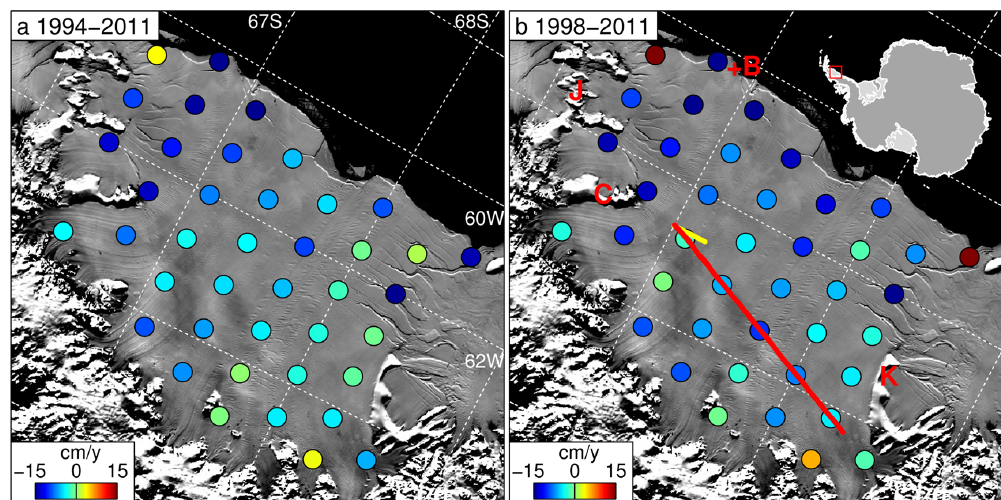
Figure 1. MODIS Mosaic of Antarctica imagery of LCIS (Scambos et al., 2007) showing the location of satellite radar altimeter crossovers and estimated surface lowering rates (updated from Fricker and Padman, 2012, as described in Sect. 2.5) for two periods: (a) 1994–2011, the full period for which ERS-1/2 and Envisat data are reliable, and (b) 1998–2011, the period for which we have radar surveys. The main survey line is shown in red, with the 2012 survey shown in yellow. (b) shows geographical features referred to in the text: B is Bawden Ice Rise; C is Churchill Peninsula; J is Jason Peninsula; K is Kenyon